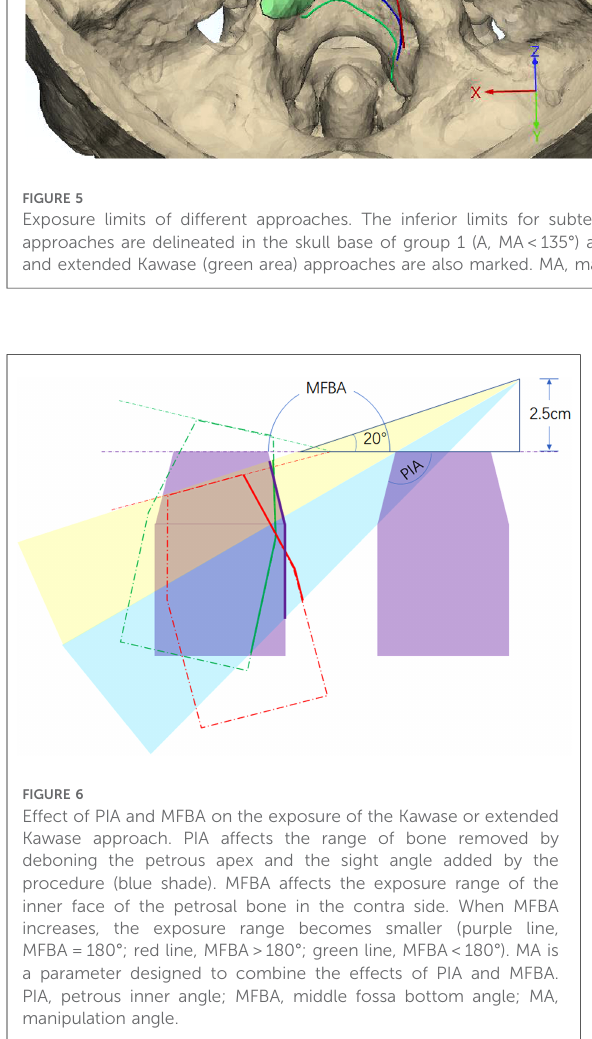
petrosal ridge becomes relatively lower in perspective, and the exposure area decreases. MA is a parameter combining the effects of PIA and MFBA. As proven by the results of the current study, MA shows an inverse linear correlation with the added exposure of the Kawase or extended Kawase approach. By dividing the cases into two groups based on whether MA is less than 135°, the volume and area gained by removing the bone surrounding the petrosal apex will be larger in the group with MA < 135°.